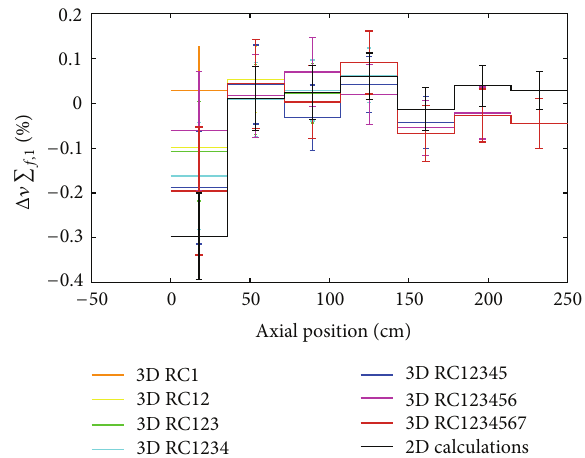
Figure 22: Relative differences between fission neutron production cross sections for the fast group.